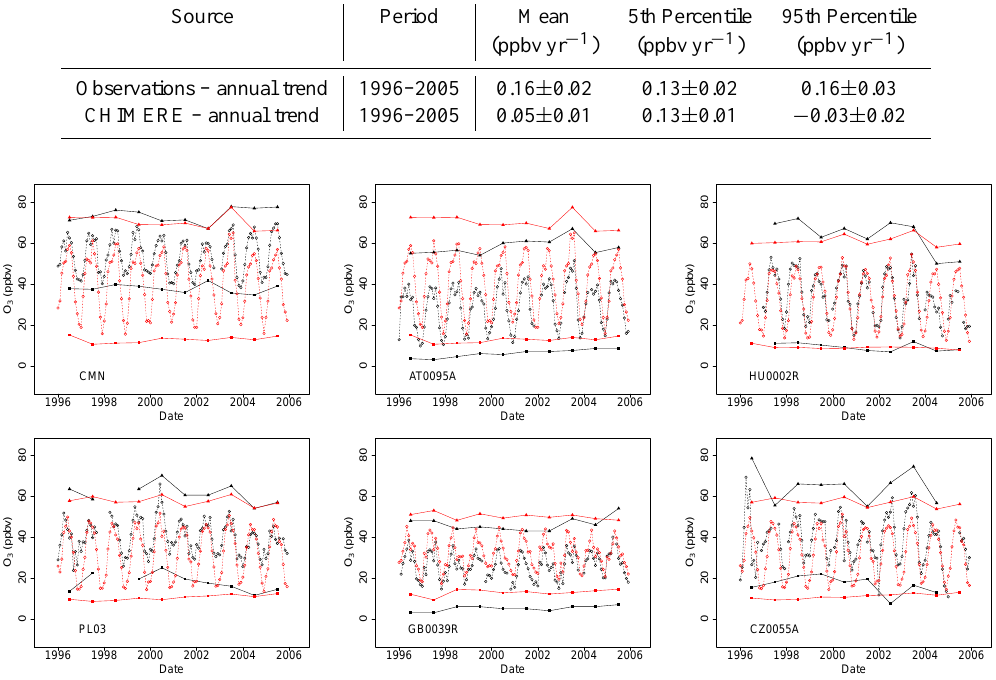
Fig. 11. Examples of loess trends of observed (black) and CHIMERE simulated (red) monthly mean O 3 (ppbvyr − 1 ) (Full details of observed sites given in Fig. A1 of the Supplement, full CHIMERE simulated sites given in Appendix B Fig. B1 of the Supplement). Circles=monthly mean, squares=annual 5th percentile, triangle=annual 95th percentile